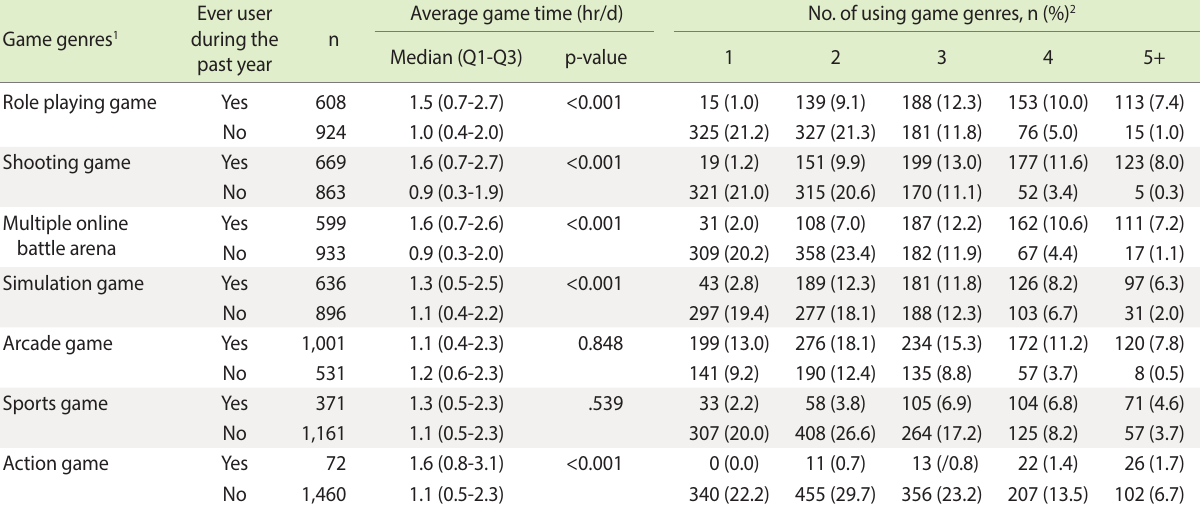
Table 2. Experience of game genre, daily average time spent and number of game genres Game genres